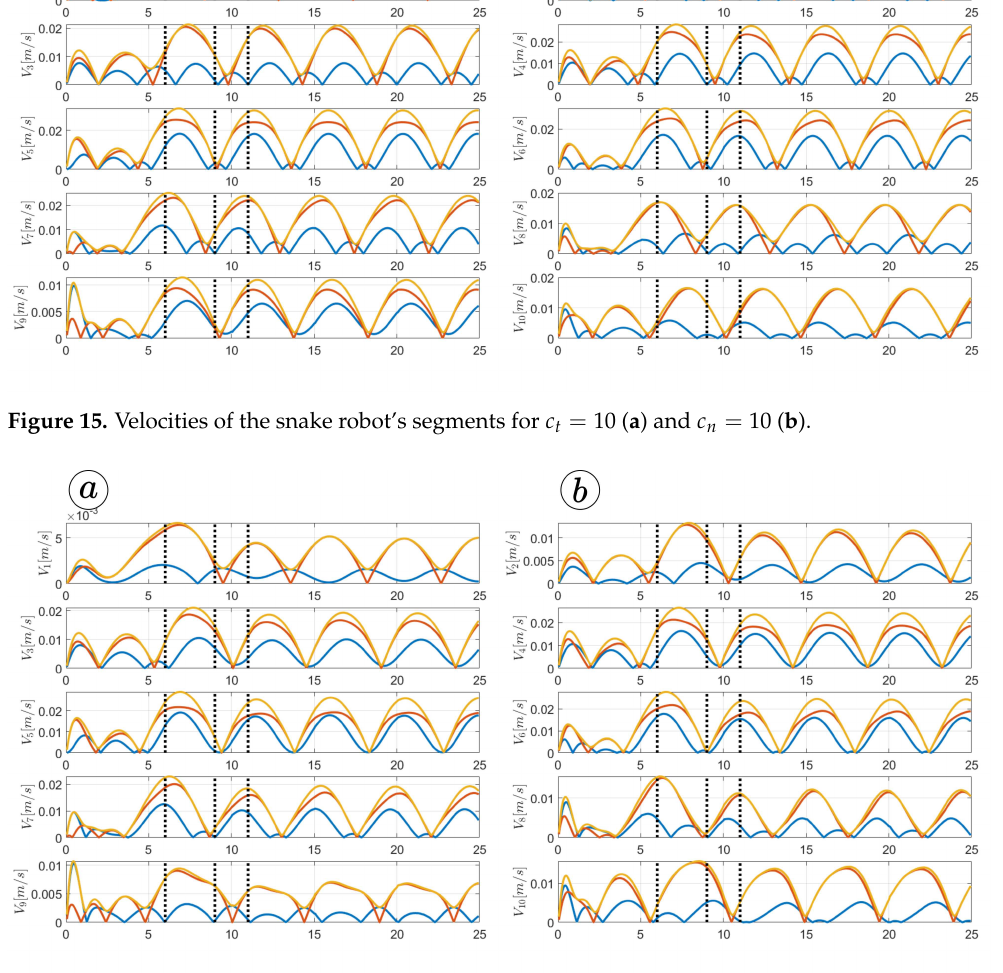
Figure 16. Velocities of the snake robot’s segments for c t = 10 ( a ) and c n = 0 ( b